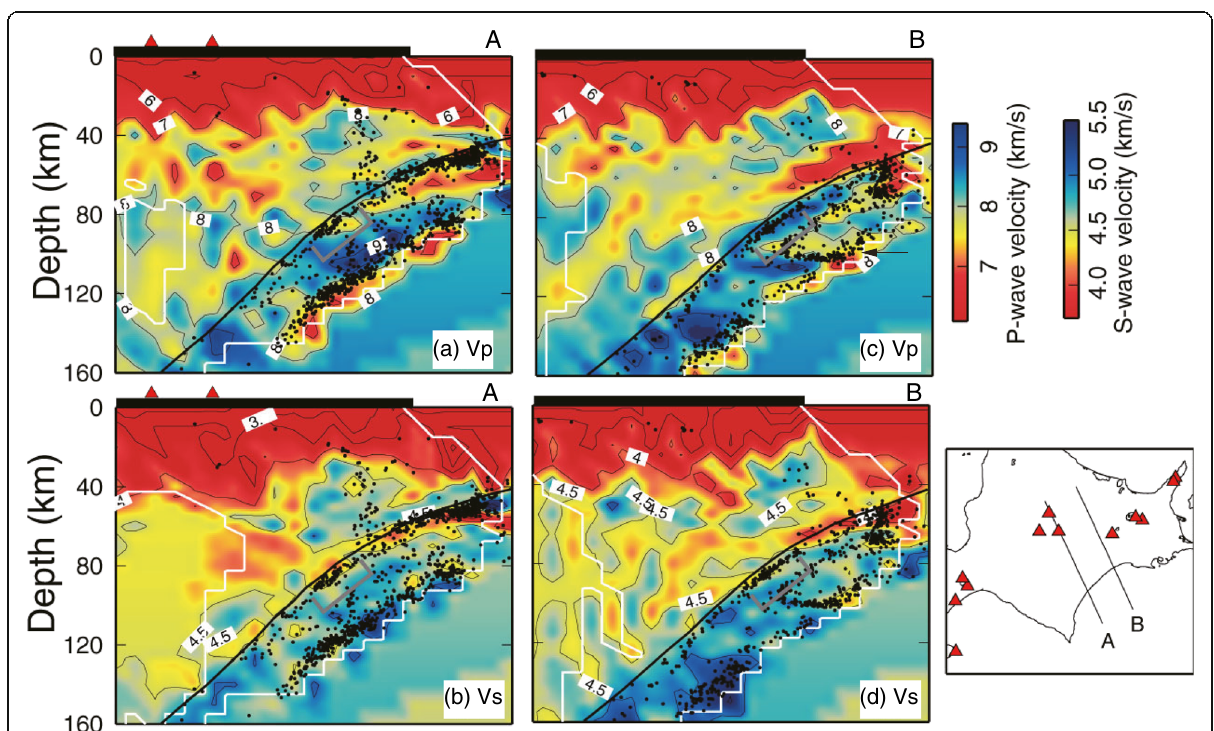
Fig. 20 Seismic velocity structure along the lower seismic plane under eastern Hokkaido. Shown are across-arc vertical cross-sections of a , c P-wave velocity and b , d S-wave velocity under eastern Hokkaido. P- and S-wave velocities along two lines in the inset map are shown by the color scales at the right . Aftershock activity of the 1993 M 7.5 Kushiro – Oki intraslab earthquake is shown by an arrow in c . Solid lines denote the upper surface of the subducting slab. Solid lines and red triangles at the top show the land area and active volcanoes, respectively. (After Nakajima et al.